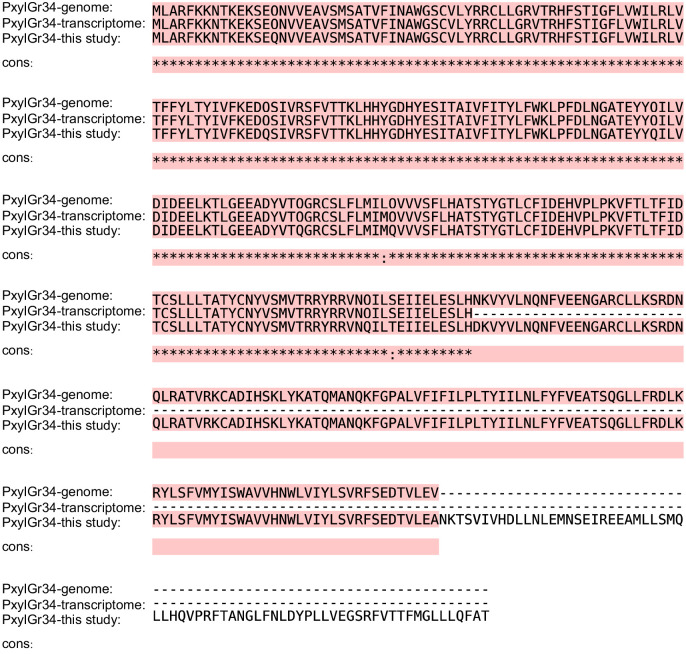
Alignment of amino acid sequences of PxylGr34 from genomic data (Engsontia et al., 2014), transcriptomic data (Yang et al., 2017), and this study.